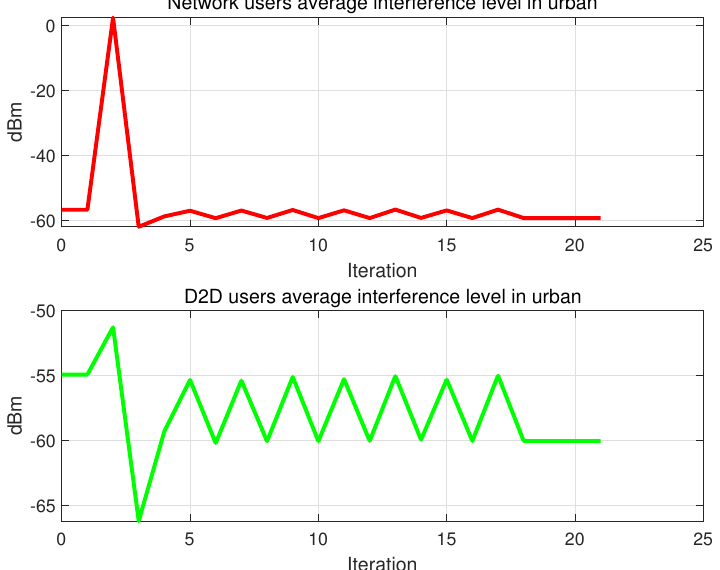
Figure 16. Mean interference level in urban environment along GADIA